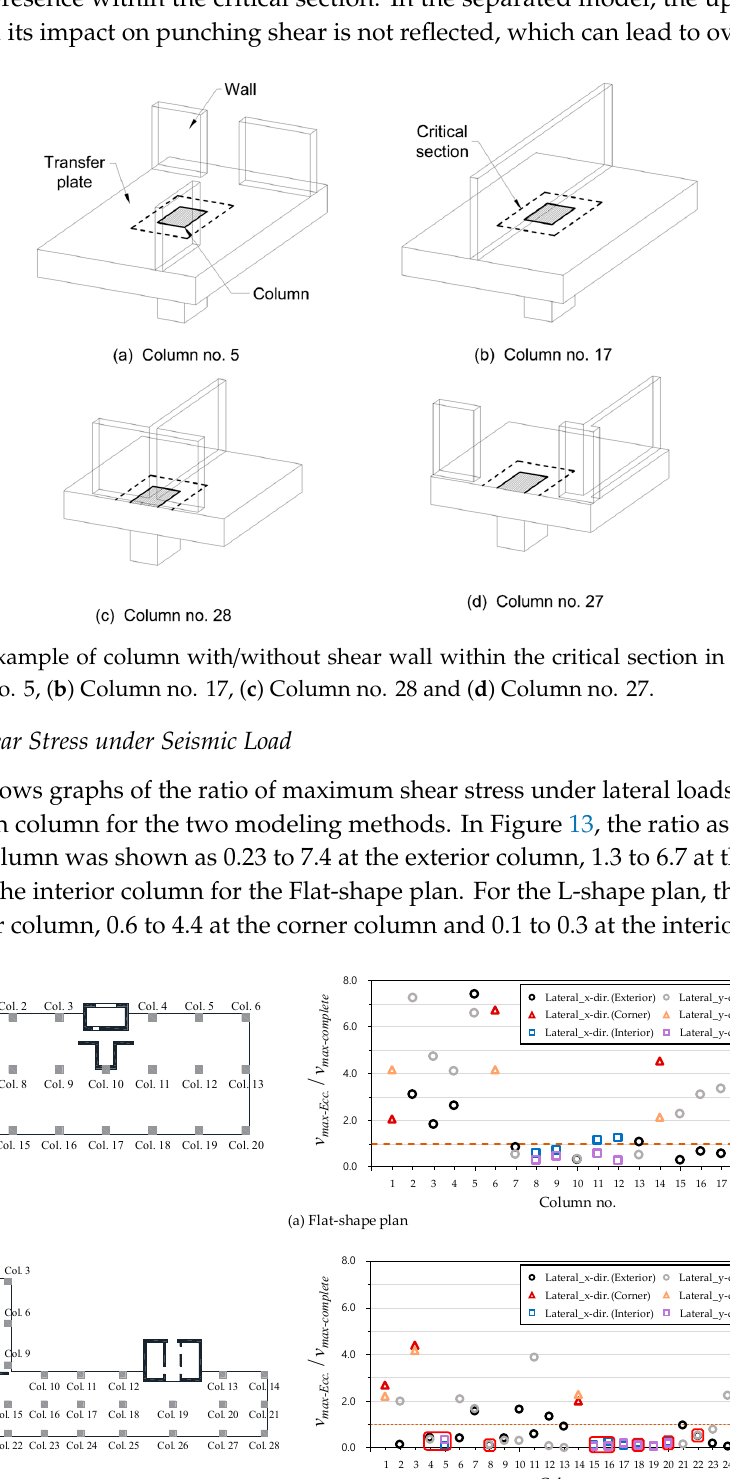
Figure 14. Moment transfer under later load. In the eccentric shear stress model, the moment is transferred by eccentric shear acting on the critical section. The ratio is calculated according to Equation (2), and up to 44% of the moment can be transferred by eccentric shear. Since the eccentric shear stress model presented in ACI 318-19 is derived from the experiment of relatively thin flat plates [29], it does not accurately simulate eccentric shear caused by the moment. Moment acting on the critical section can be supported by bending in a